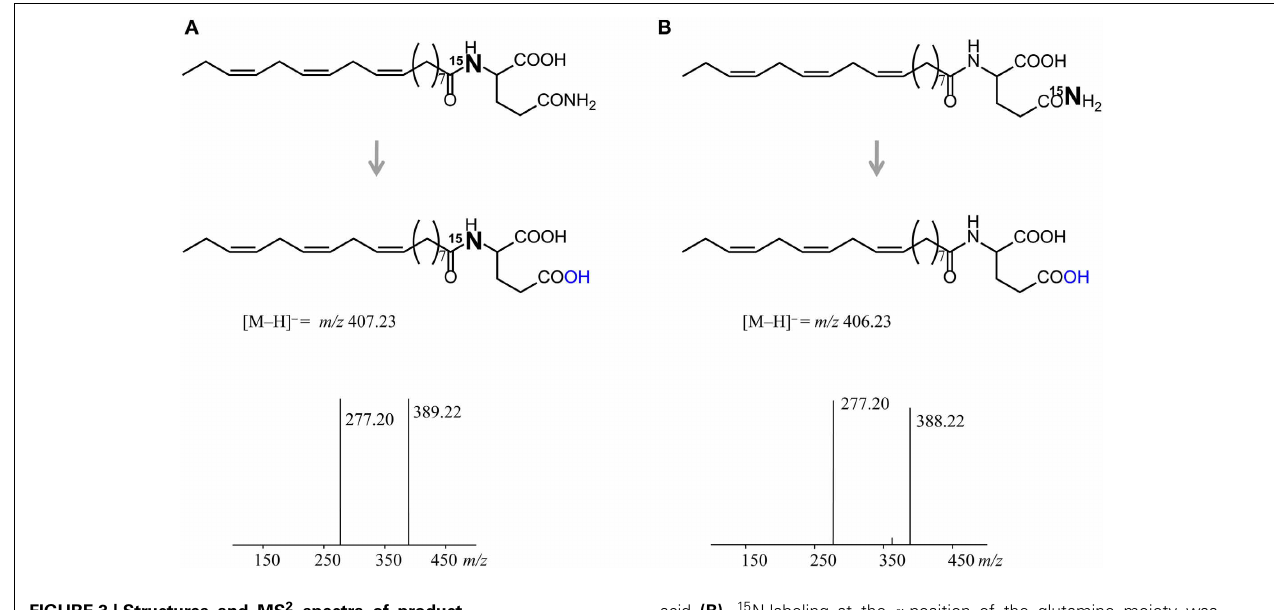
acid (B) . 15 N-labeling at the α -position of the glutamine moiety was passed to corresponding glutamic acid conjugate, whereas 15 N-labeling at the γ -position (side chain of glutamine) was cleaved off during its